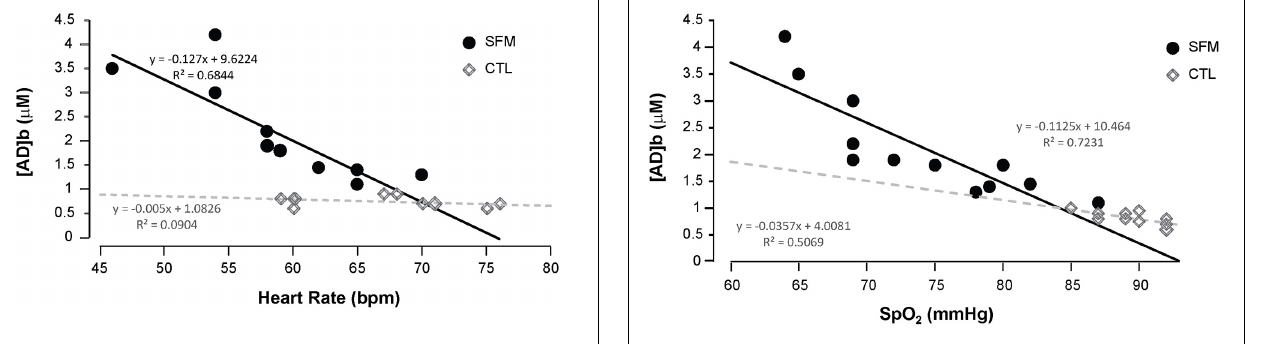
FIGURE 2 | Correlations between the minimal heart rate recorded during the apnea and the blood adenosine concentration in spearfishermen (SFM) and control (CTL) subjects.